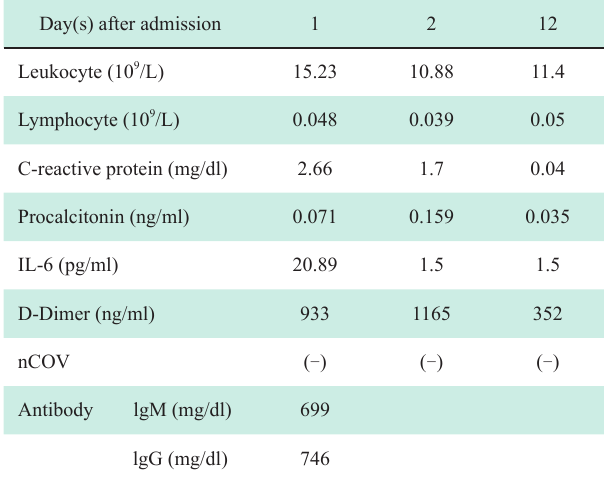
Table 2 Laboratory results (part